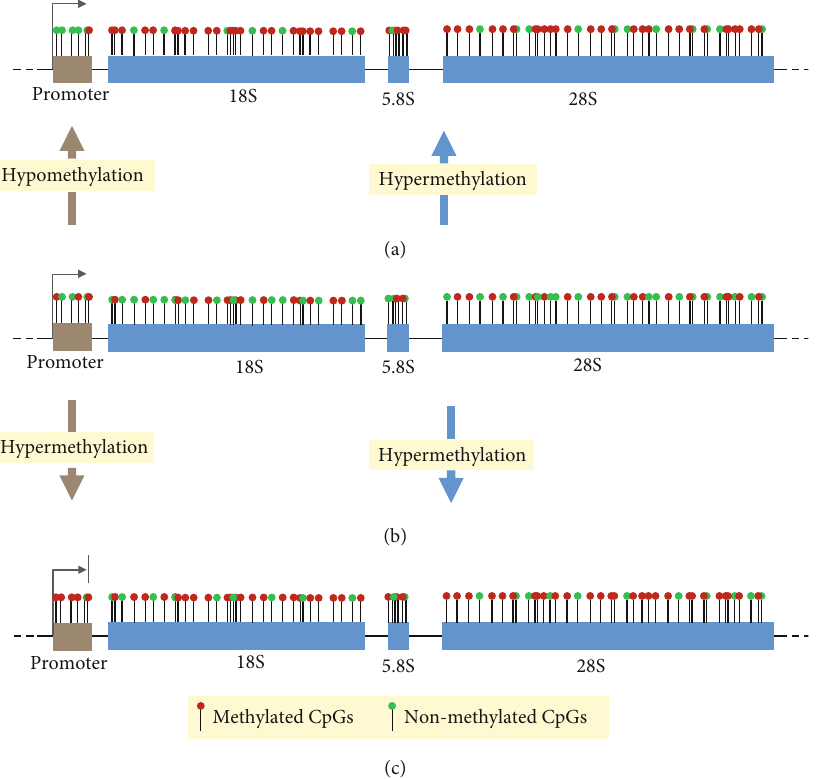
Figure 2: Schematic diagram of the rDNA methylation status between normal (b) and cancer (a) and aging (c) cells. Each vertical bar with circles in red and green represents methylated and non-methylated CpGs,